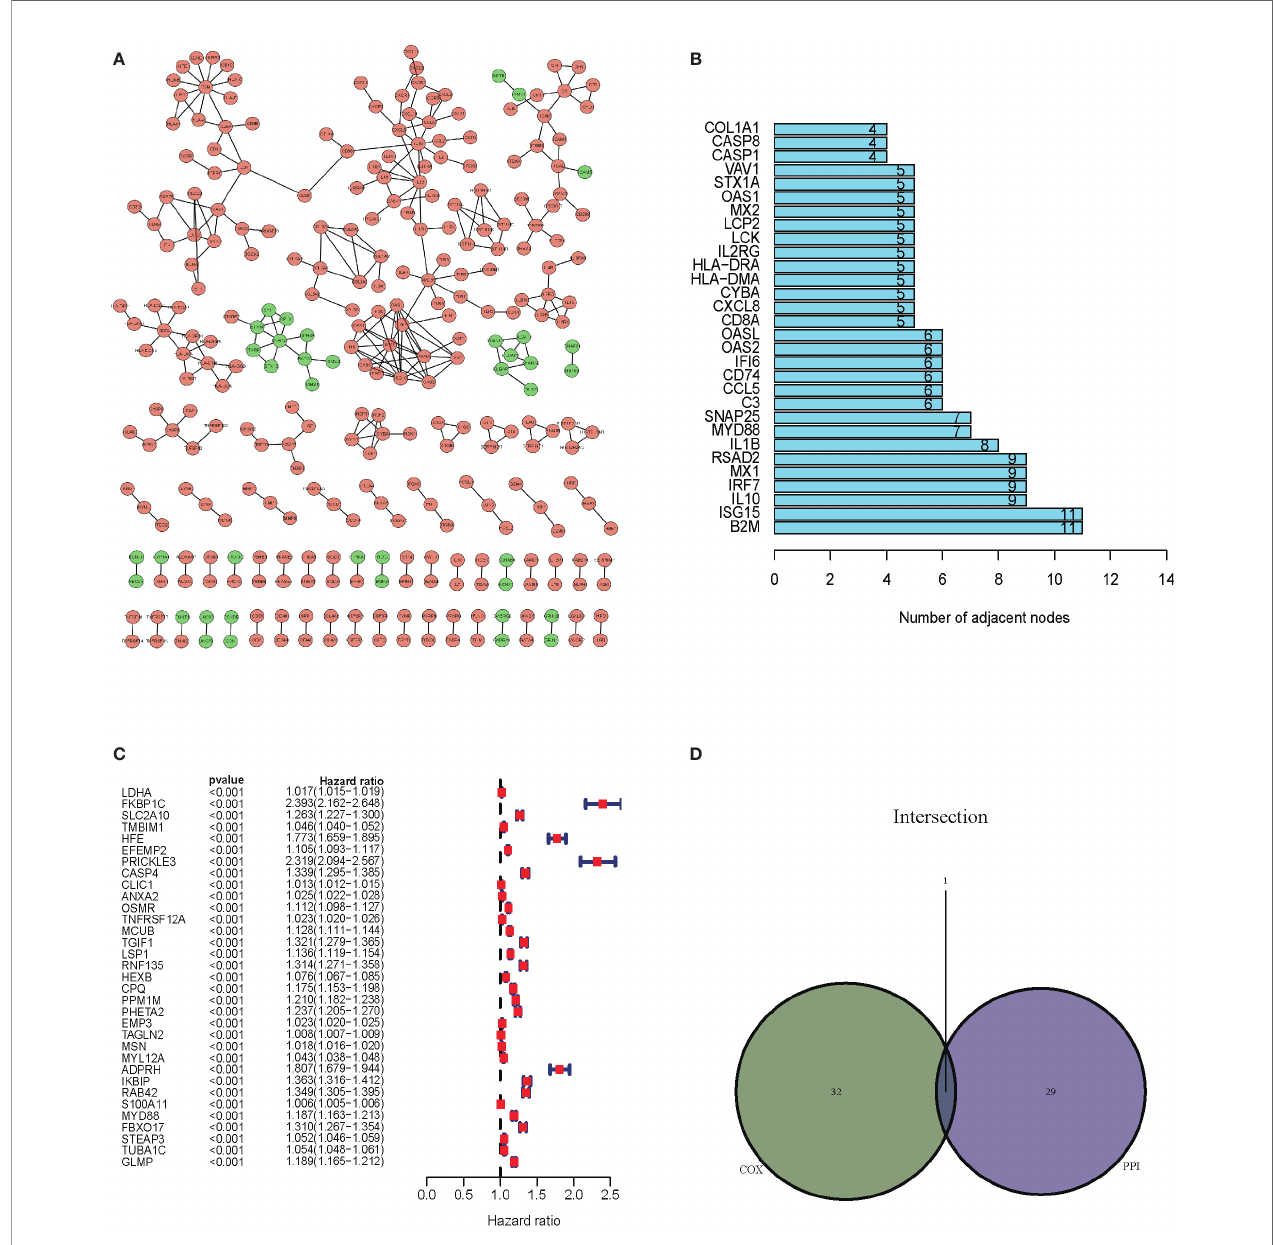
FIGURE 3 | MYD88 was screened by the intersection of PPI network and univariate Cox analysis. (A) PPI network of the DEGs. (B) The top 30 proteins that had the maximum number of nodes in the PPI network. (C) Univariate Cox regression analysis for the survival of glioma patients. (D) The intersection analysis between the top 30 nodes in PPI network and the leading 33 genes ranked by the p-value of univariate Cox regression showed that MYD88 was the key